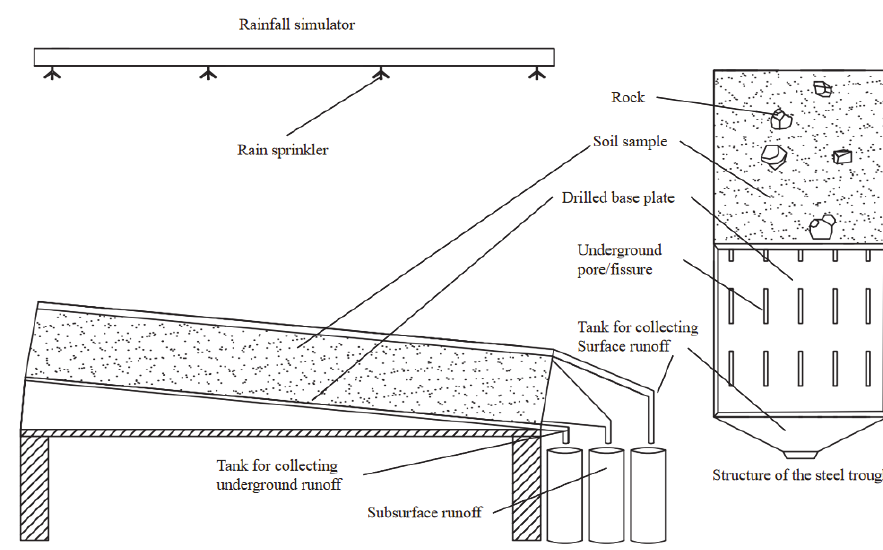
Figure 3. Simulated rainfall device and steel trough device diagram.